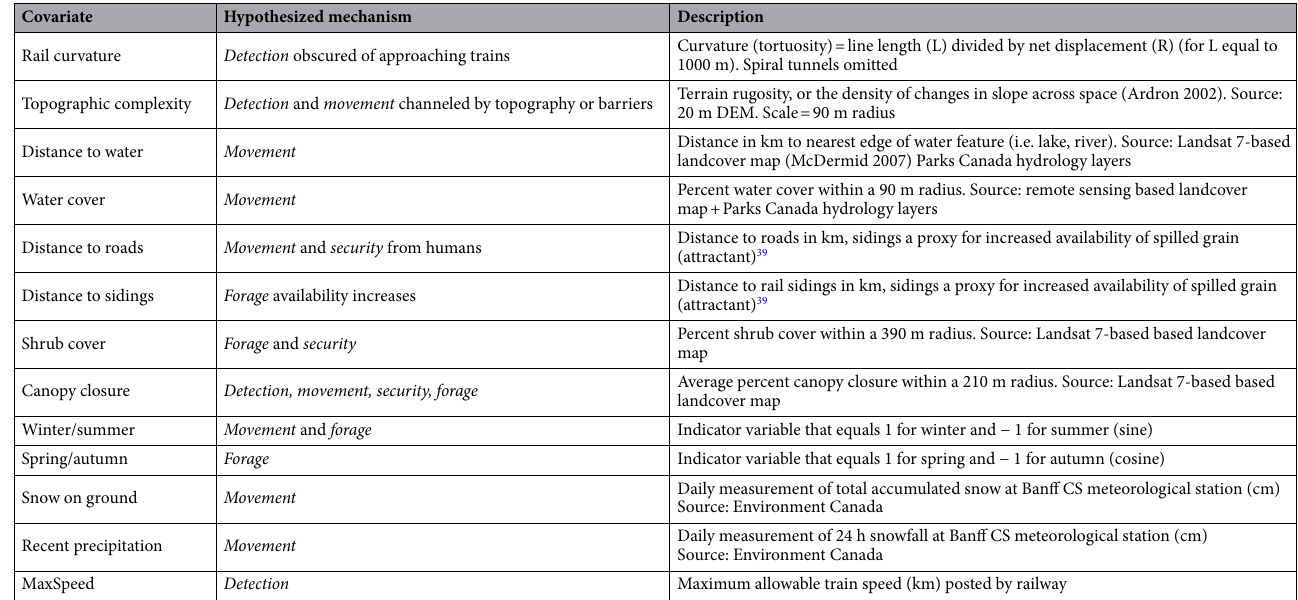
Table 2. Explanatory variables used in modelling animal-train collisions for three guilds of large mammals (bears, other carnivores, and ungulates) in Banff and Yoho National Parks, Canada between 1995 and 2018, along with the hypothesized mechanism by which these variables may influence probability of